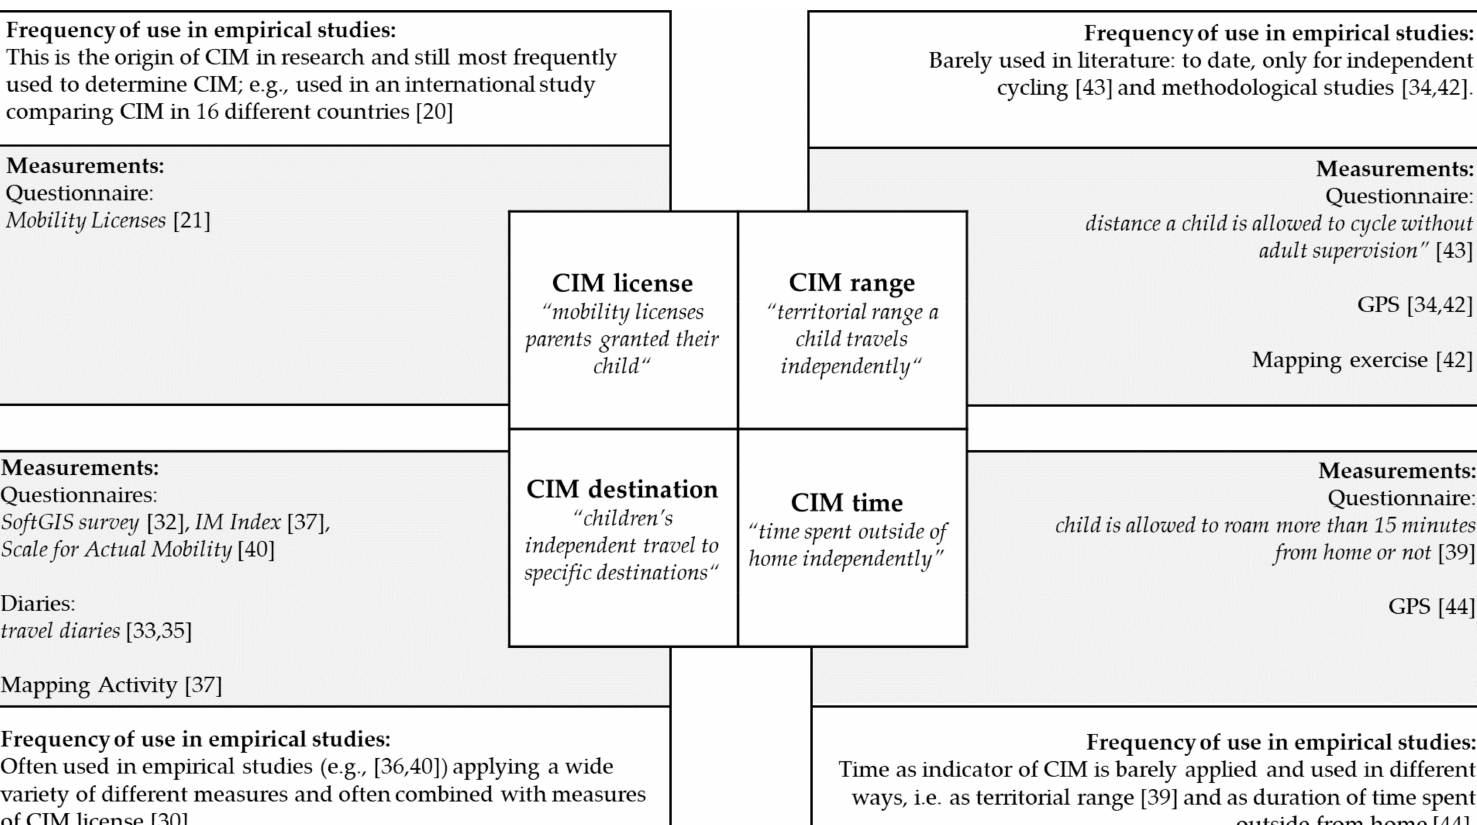
Figure 1. Definitions, measures, and frequency of application in empirical projects of four children’s independent mobility (CIM)